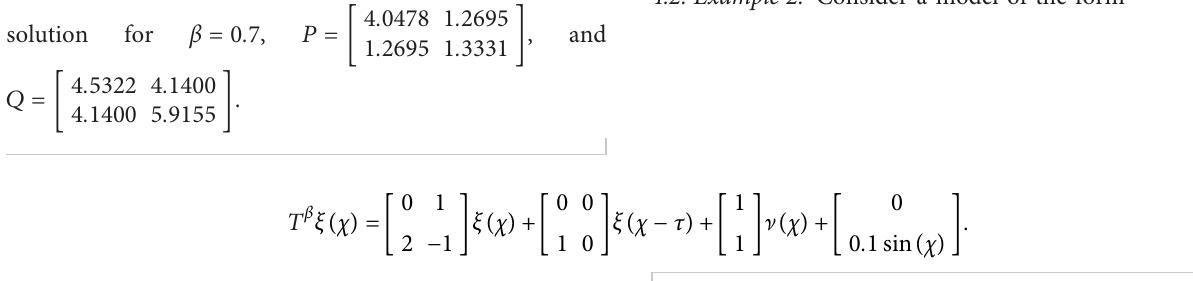
Figure 5: Te evolution of state ξ